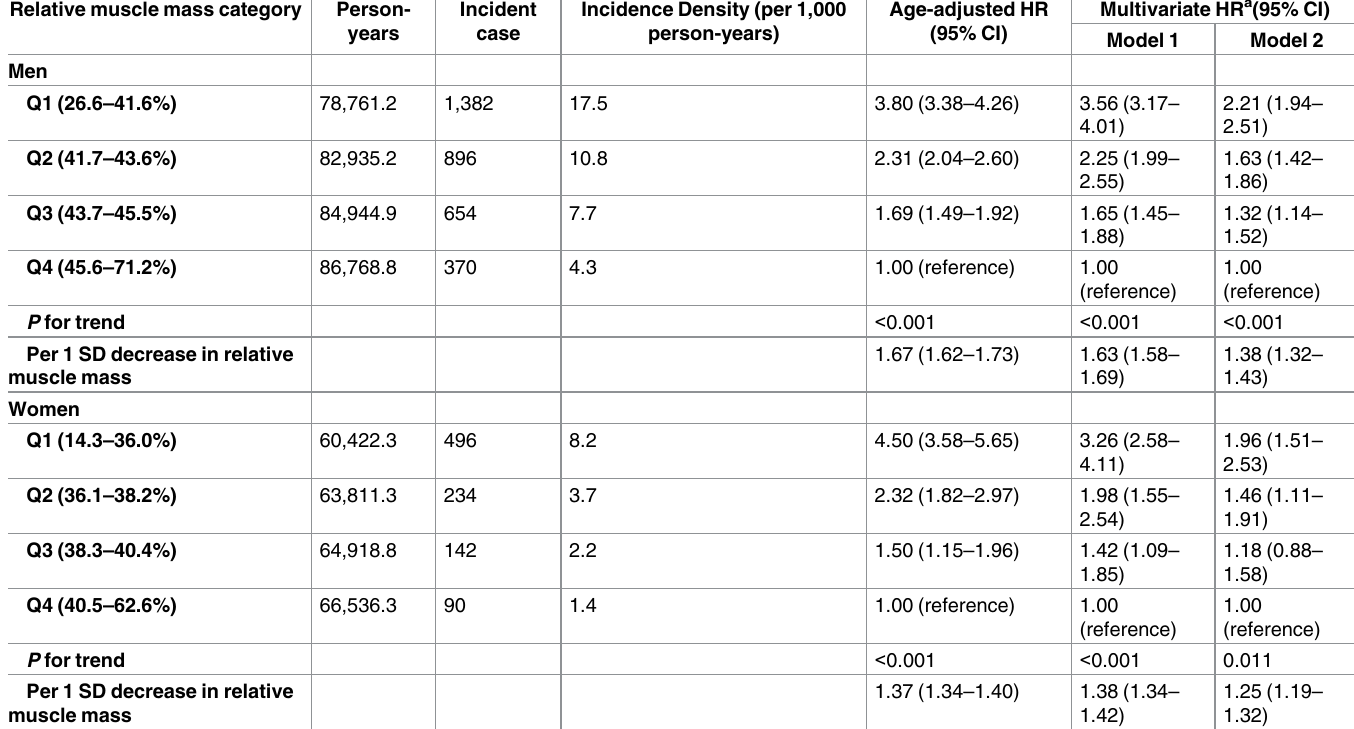
Table 3. Development of type 2 diabetes by relative muscle